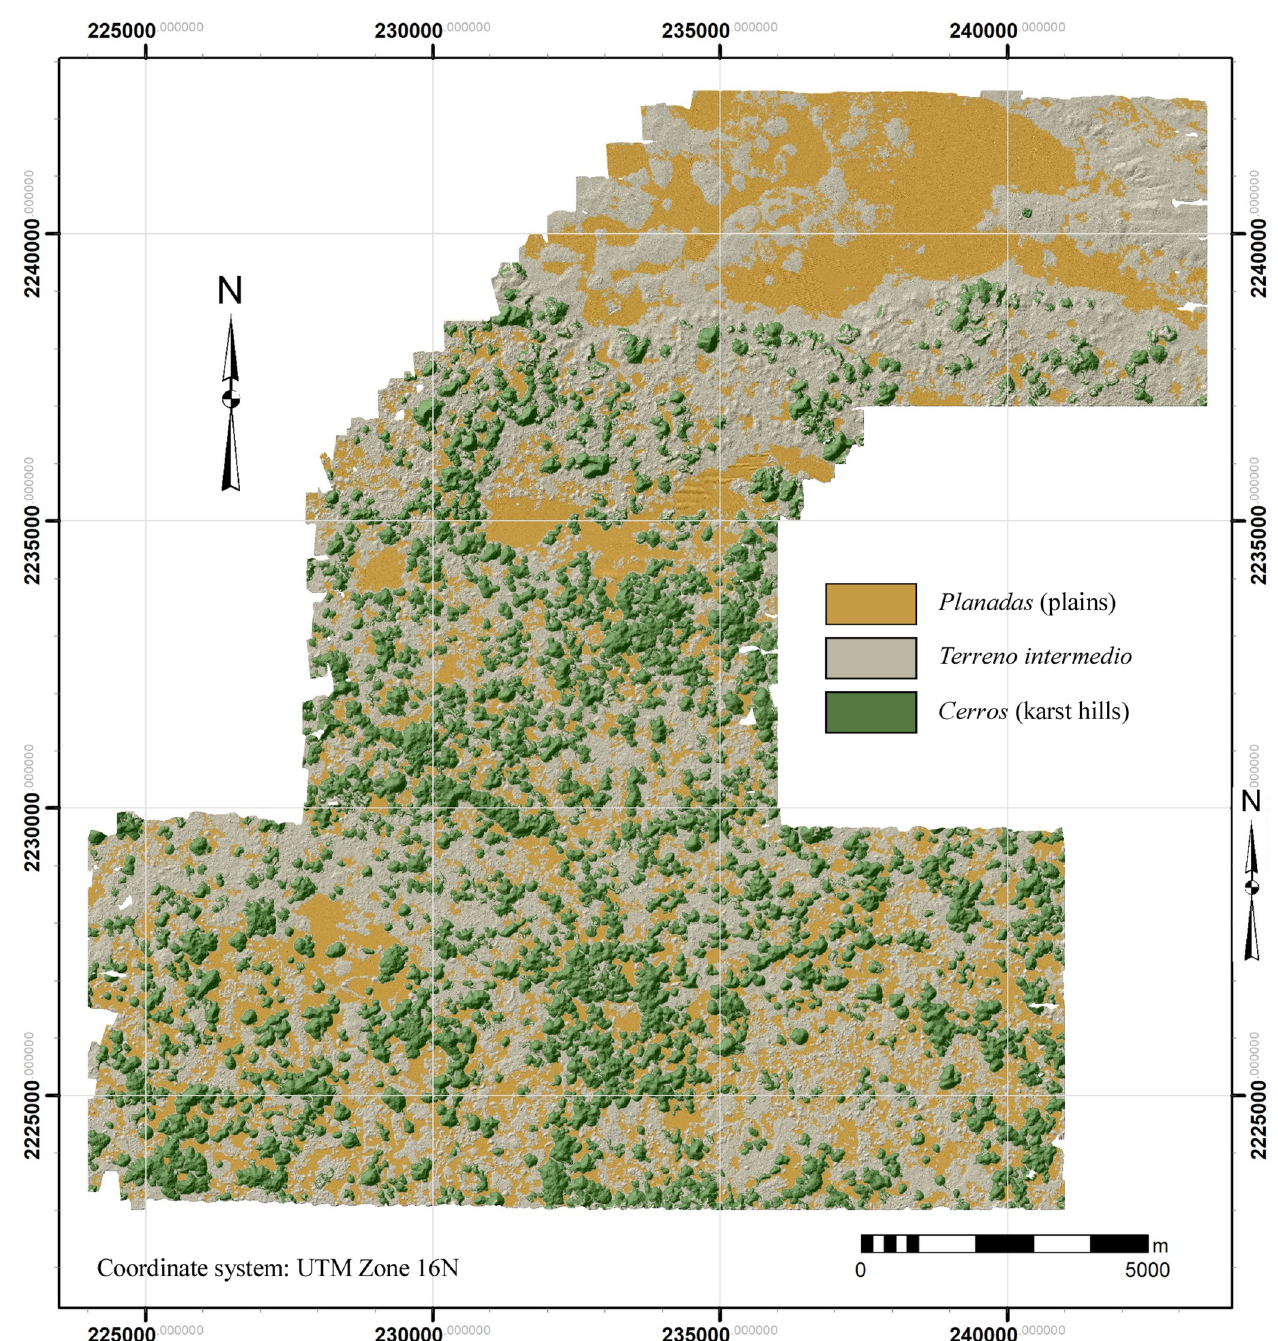
Fig 10. Map of the major classified landforms within the NCALM lidar